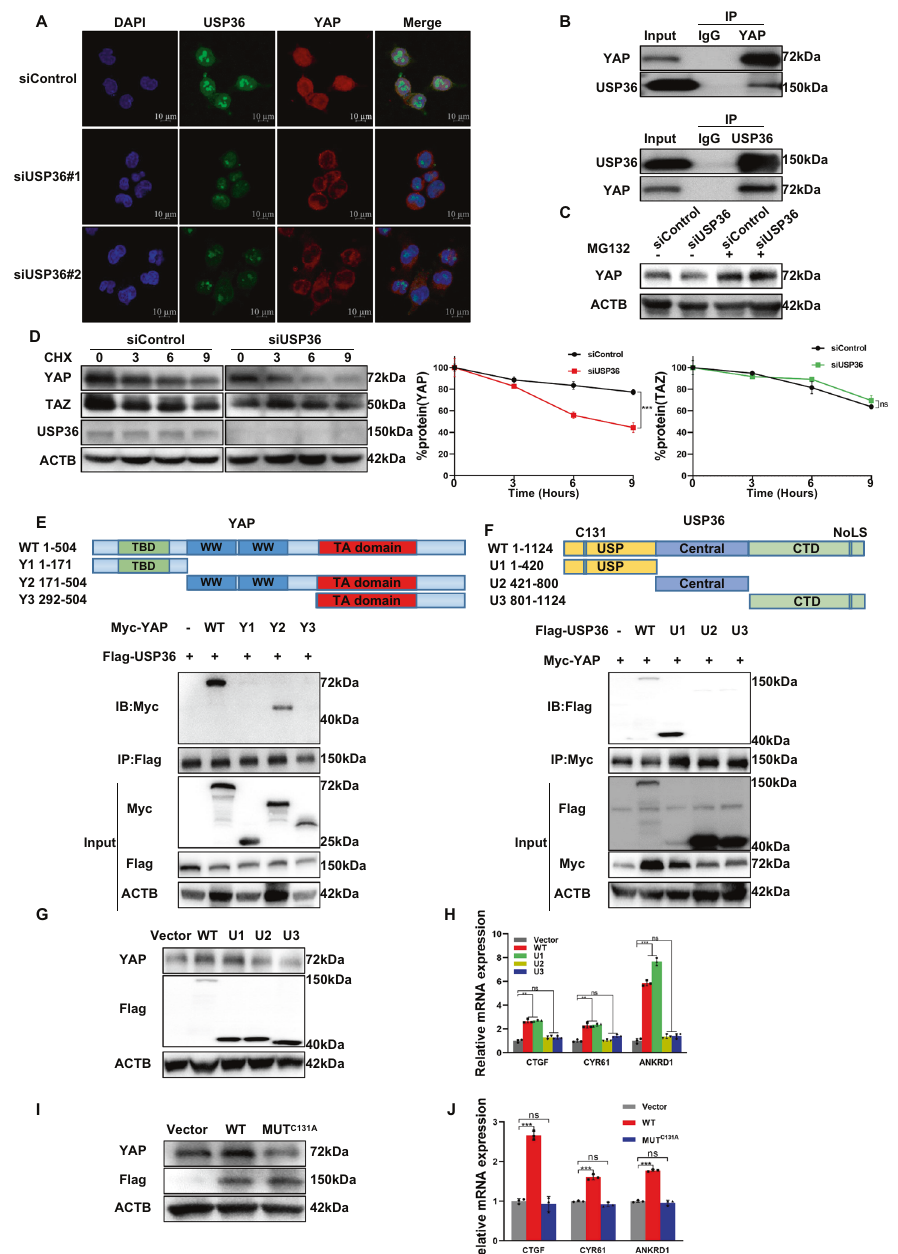
Fig. 5 USP36 expression is positively correlated with YAP expression and interacts with YAP in ESCC cells. A Immunostaining demonstrated the colocalization of USP36 (green) and YAP (red) in ECA109 cells. Blue denoted cell nuclei. Scale bar, 10 µm. B Representative immunoblots to show the interaction between USP36 and YAP as assessed by immunoprecipitation (IP) for USP36 or YAP, compared to isotype control (IgG). C Control or USP36-slienced ECA109 cells were treated with MG132 (10 μ M) for 24 h. YAP and USP36 protein were measured by immunoblotting. Depletion of USP36 decreased YAP protein levels, and this effect could be attenuated by MG132. D USP36 depletion decreased the YAP protein half-life in ECA109 cells. The cells were treated with 100 µmol/L CHX for the indicated time before being collected for western blot assays. Quantitative analysis of halftime of YAP and TAZ protein in ( D ). E Representative immunoblots to show the interaction between USP36 and WTor truncated YAP as indicated assessed by immunoprecipitation (IP) with USP36 (Flag). YAP binded to USP36 at its WW domain. (Top panel) Schematic diagram of vectors expressing Myc-tagged wild-type or serial deletion mutants of YAP. (Bottom panel) The WW domain of YAP interacted with USP36. F Representative immunoblots to show the interaction between YAP and WT or truncated USP36 as indicated assessed by immunoprecipitation (IP) with YAP (anti-Myc). USP36 binded to YAP at its UPS domain. (Top panel) Schematic diagram of vectors expressing Flag-tagged wild-type or serial deletion mutants of USP. (Bottom panel) The USP domain of USP36 interacted with YAP. G , H ECA109 cells were transfected with vector, WT, or truncated USP36 and then subjected to immunoblotting to examine YAP protein level or qPCR to examine YAP target gene expression. The USP domain was essential for USP36 to maintain YAP protein levels and YAP target gene expression. I , J ECA109 cells were transfected with vector, WT, or USP36 mutant(C131A) and then subjected to immunoblotting to examine YAP protein level or qPCR to examine YAP target gene expression. The C131A mutation of USP36 impaired its ubiquitination activity and reduced the ability of USP36 to maintain YAP protein levels and YAP target gene expression in ECA109 cells. ** P < 0.01, *** P <